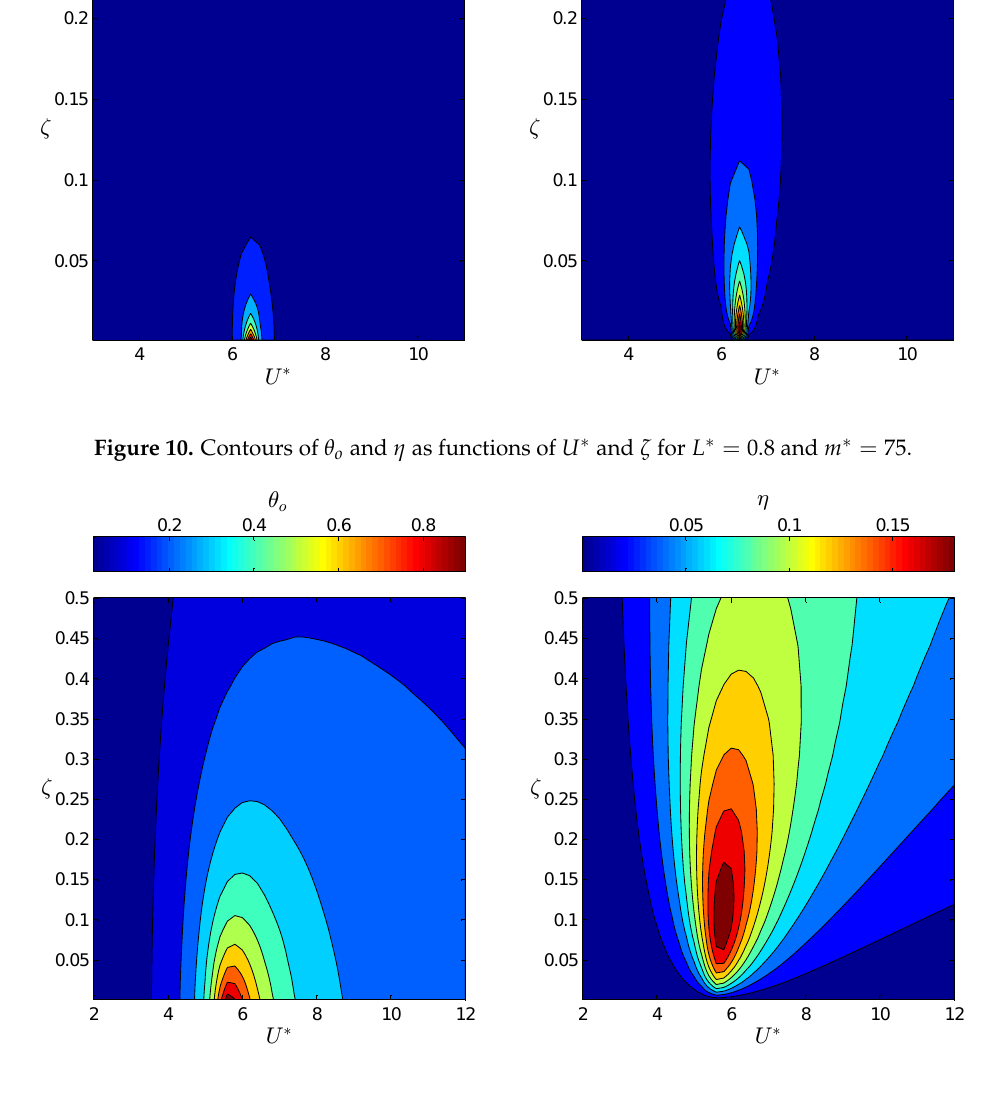
Figure 11. Contours of θ o and η as functions of U ∗ and ζ for L ∗ = 0.8 and m ∗ =